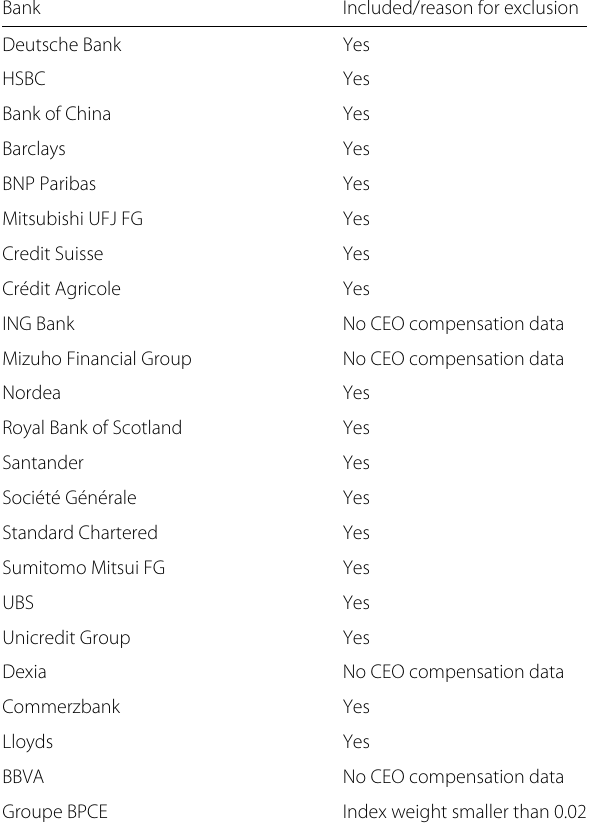
Table 13 List of non-US global systemically important banks (G-SIBs), 2011–2012